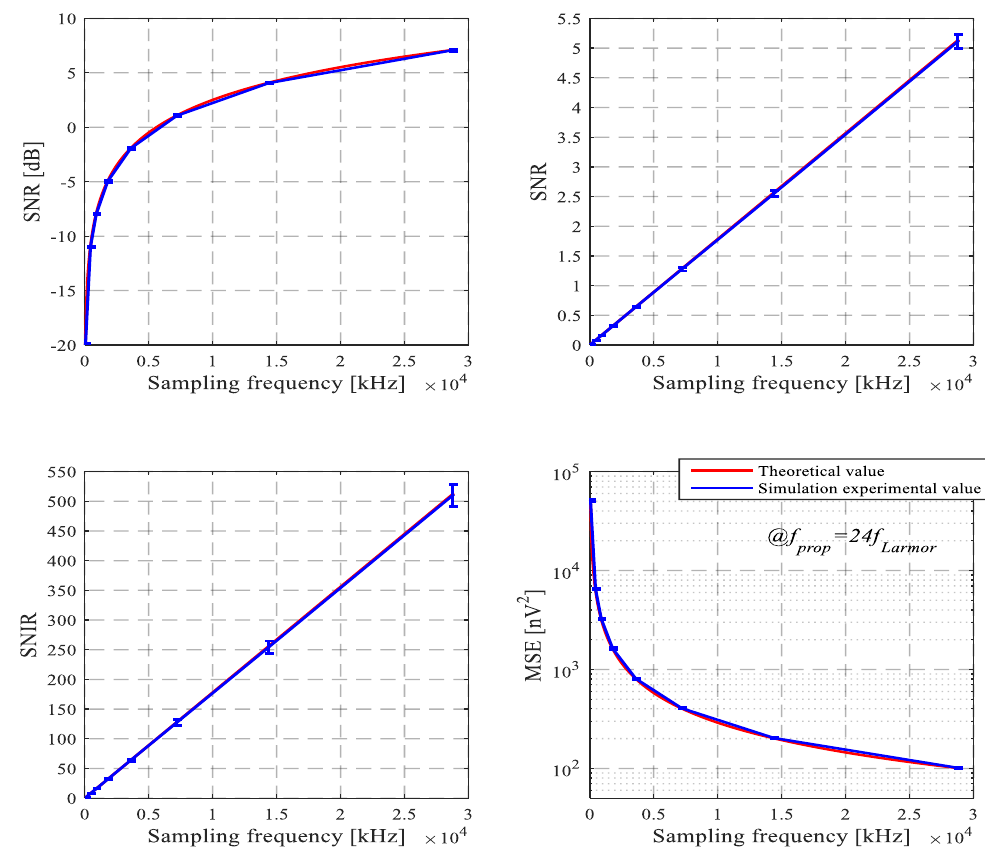
Figure 6. The curves of signal to noise ratio (SNR), signal-to-noise improvement ratio (SNIR), mean squared error (MSE) with increasing sampling frequency by rectangular sparse reconstruction.